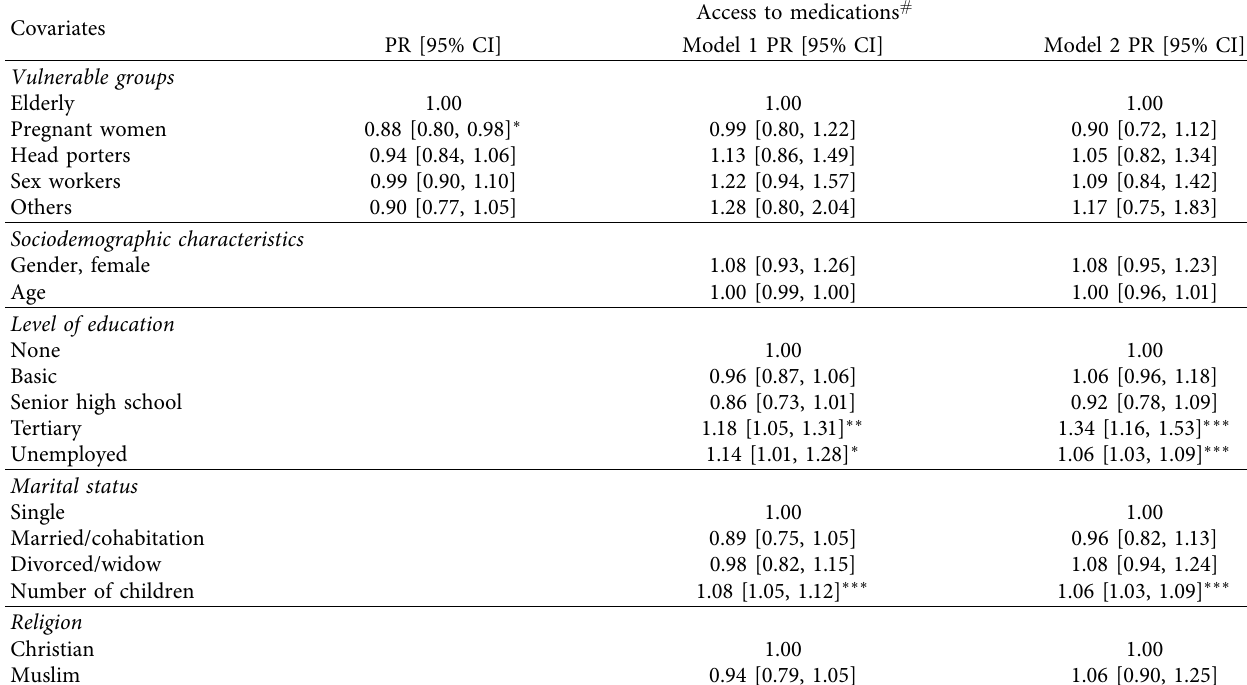
Table 5: Prevalence ratios and 95% CI for the association between the type of vulnerability and healthcare